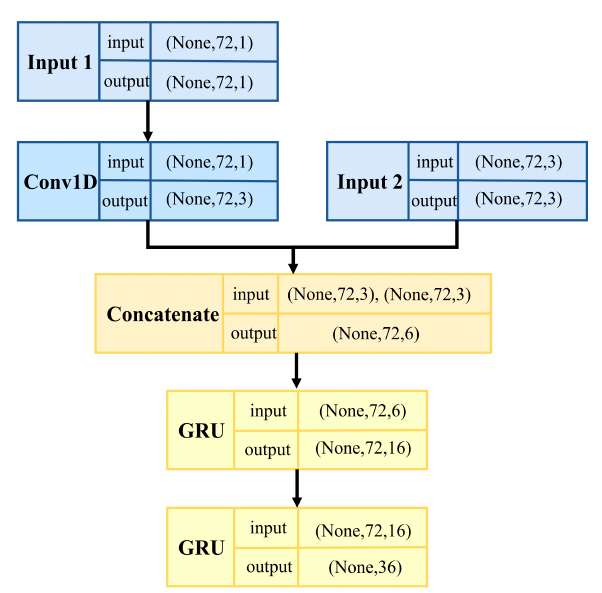
Figure 10. The structure of the Con-GRU-I model.